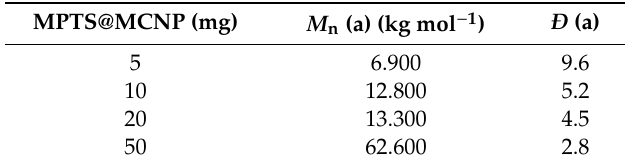
Table 4. SEC results for PS obtained by free radical polymerization in the presence of different amounts of MPTS@MCNP as chain transfer agent